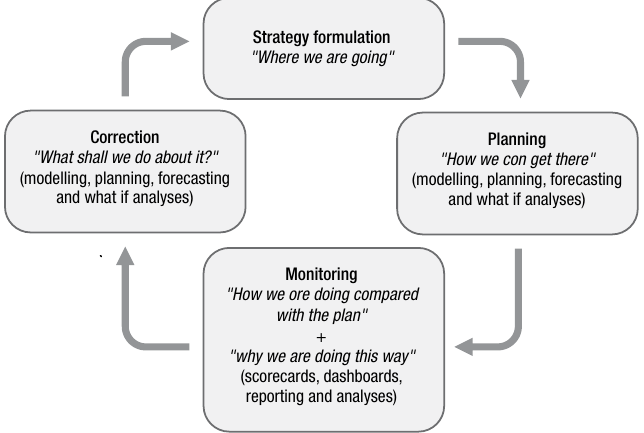
Fig. 1. Four basic steps of CPM (source: designed by the author)